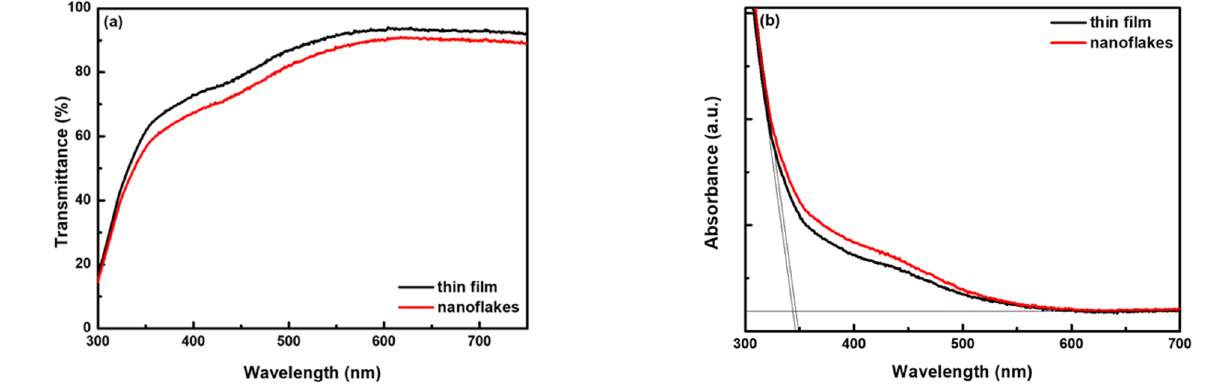
Figure 3. ( a ) Transmission and ( b ) absorption spectra of the NiO x thin film and nanoflakes. The UPS spectra of the NiO x thin film and nanoflakes displayed in Figure 4 to ex- amine whether the energy levels of NiO x were altered due to different nanostructures.